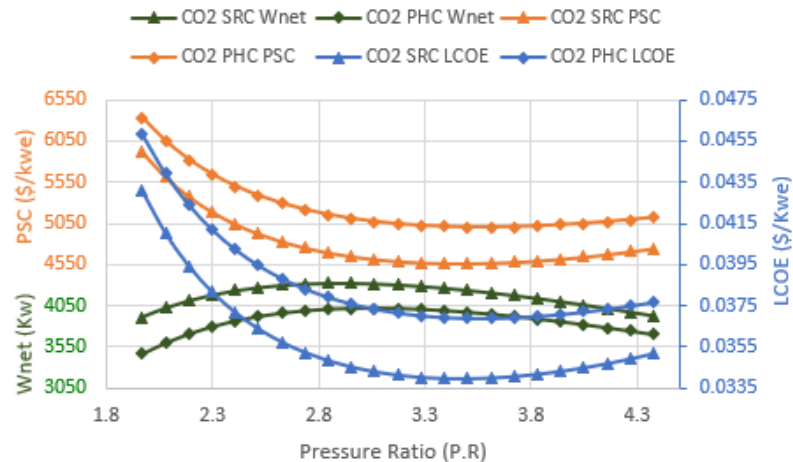
Figure 4. Power output, plant-specific cost and levelized cost of electricity for CO 2 SRC and PHC with respect to pressure ratio.